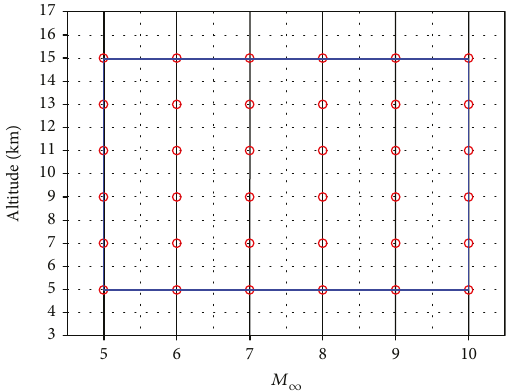
Figure 6: Operating domain (the red circles represent sampling